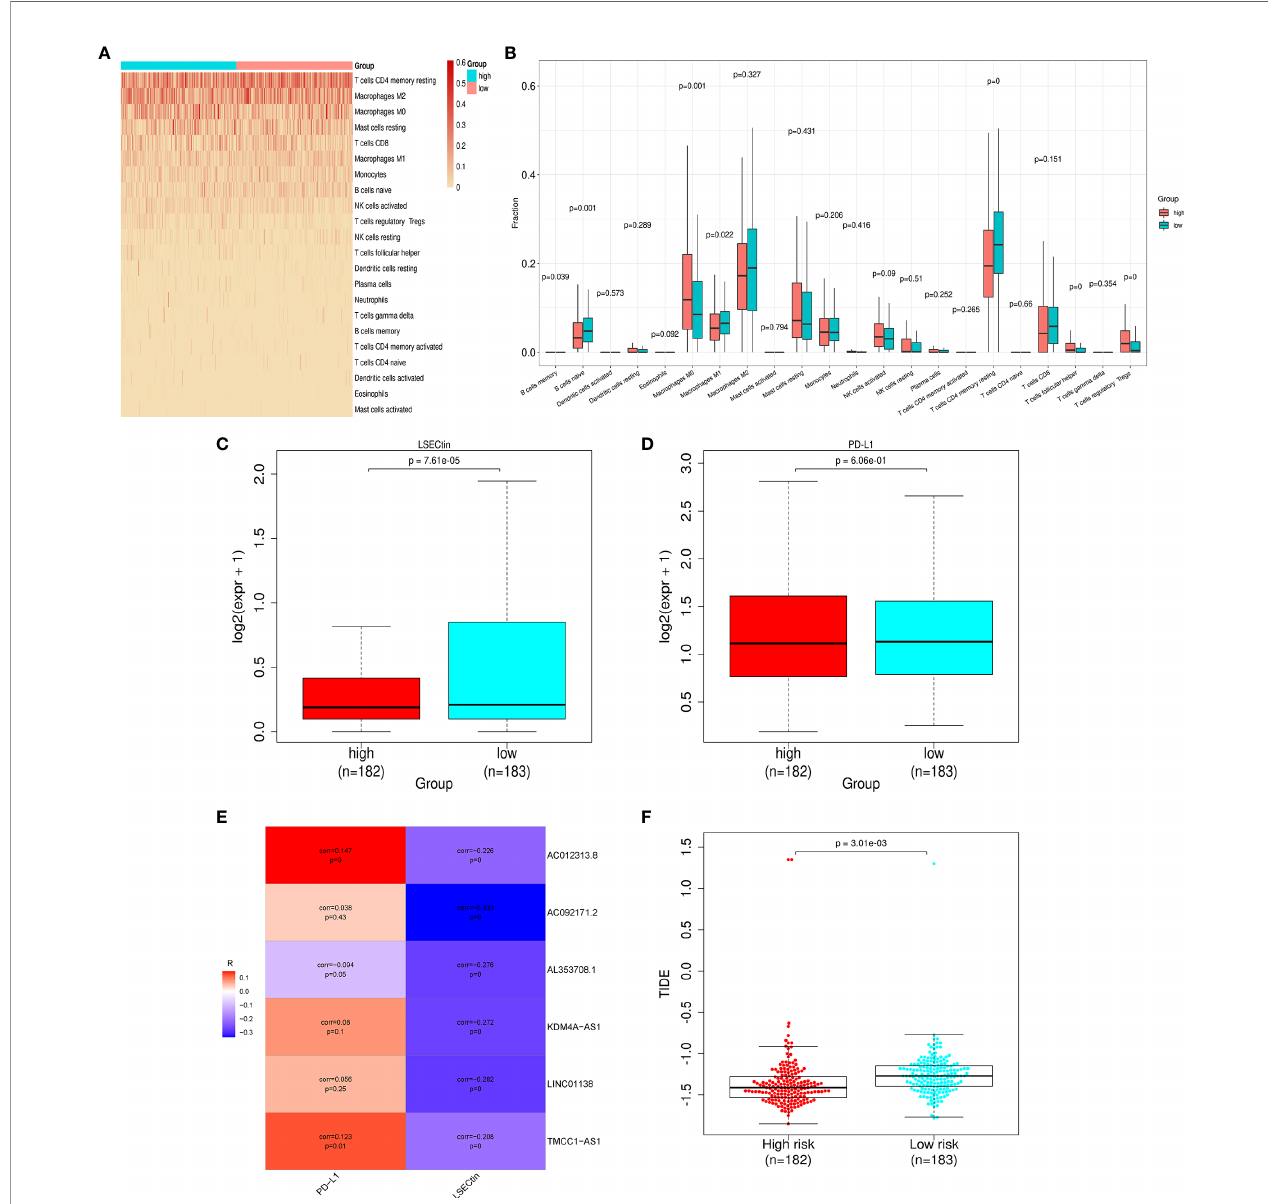
FIGURE 6 | Differences in immune in fi ltration and immune checkpoint gene expression in the high- and low-risk groups. (A) Heat map of immune in fi ltration in the high- and low-risk groups. (B) Box plot of immune in fi ltration in the high- and low-risk groups. (C) Differential LSECtin expression in the high- and low-risk groups. (D) Differential PD-L1 expression in the high- and low-risk groups. (E) The correlation between each lncRNA in the signature and immune checkpoint genes. (F) The low-risk group has a higher TIDE